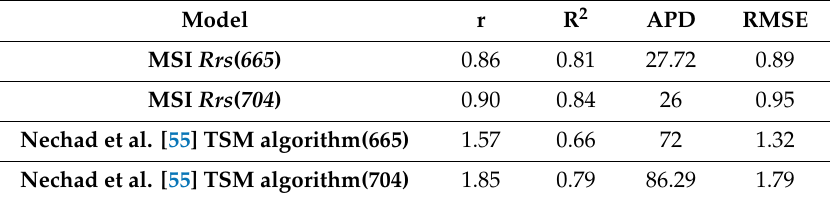
Table 3. Error metrics of the two customized TSM models and the Nechad et al. [55] TSM algorithms.